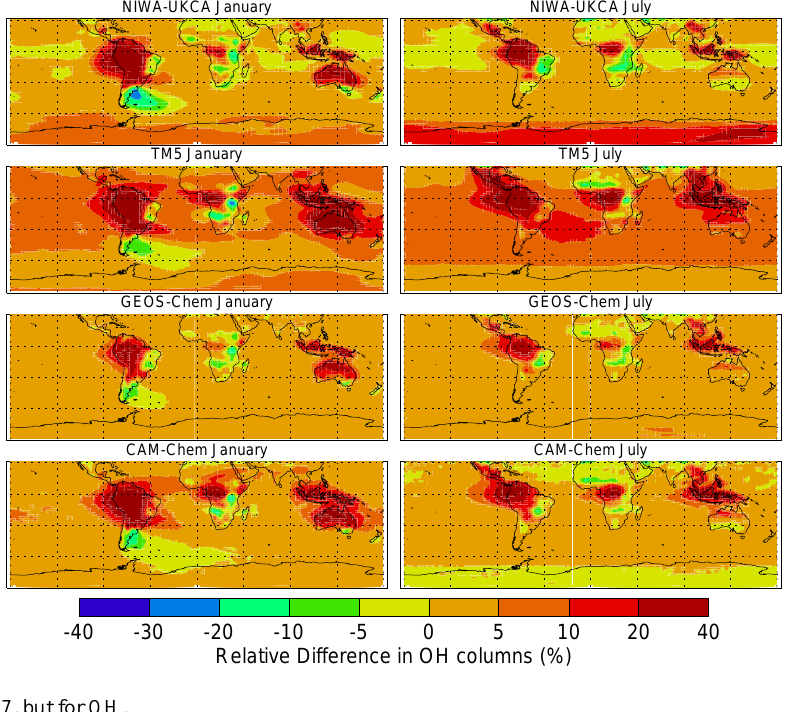
Figure 19. Same as Fig. 17, but for OH. Table 7. Relative differences (%) in tropospheric CO budget terms between CLM-MEGANv2.1 and LPJ-GUESS simulations for 2004. Total CP CP CH 4 CP NMVOCs Total CL Burden NH SH NH SH NH SH NH